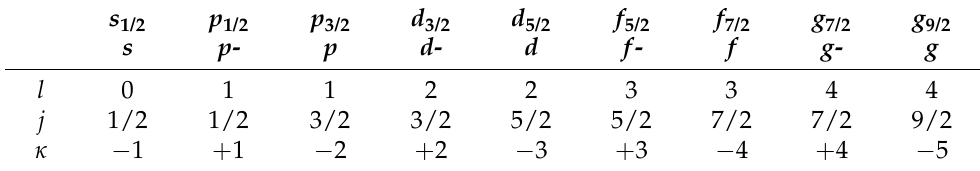
Table 1. Spectroscopic notation of relativistic